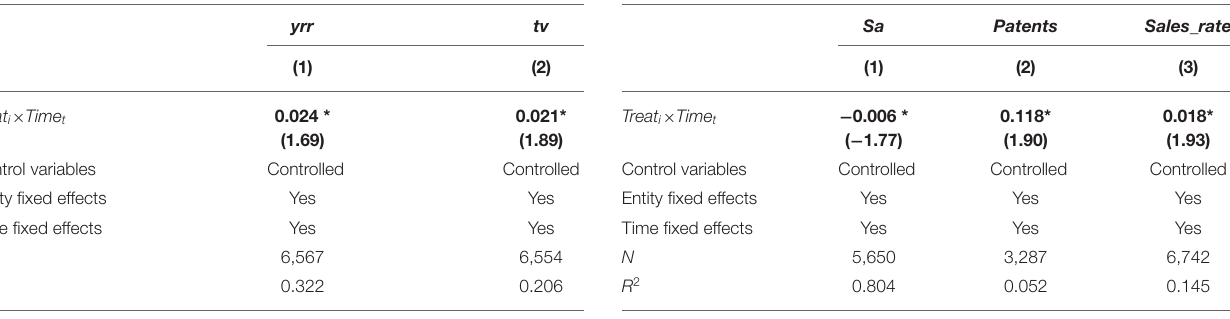
TABLE 5 | Mechanism test—capital market effect. TABLE 6 | Mechanism test—real